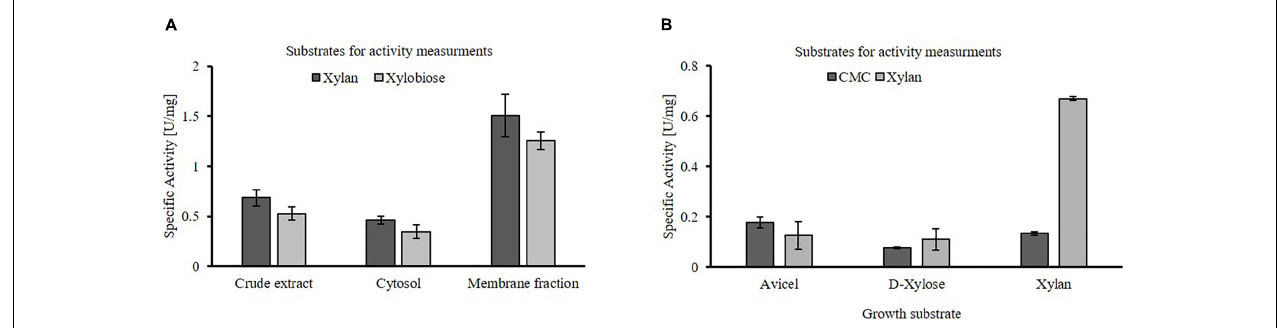
FIGURE 3 | Hydrolytic activity of Thermococcus sp. strain 2319x1E cell fractions after growth on different substrates. (A) Specific hydrolytic activity of distinct protein fractions from cells grown on beechwood xylan using xylan or xylobiose as substrate, determined by monitoring the increase of reducing sugars via the DNSA assay. The activity in crude extracts, the soluble cytosolic and the membrane fraction is shown. (B) Specific enzymatic activity in crude extracts of cells grown on either Avicel R (cid:13) cellulose, D -xylose or beechwood xylan using xylan or CMC as substrate. The enzymatic activity was determined after 30 min of incubation at 85 ◦ C using the DNSA